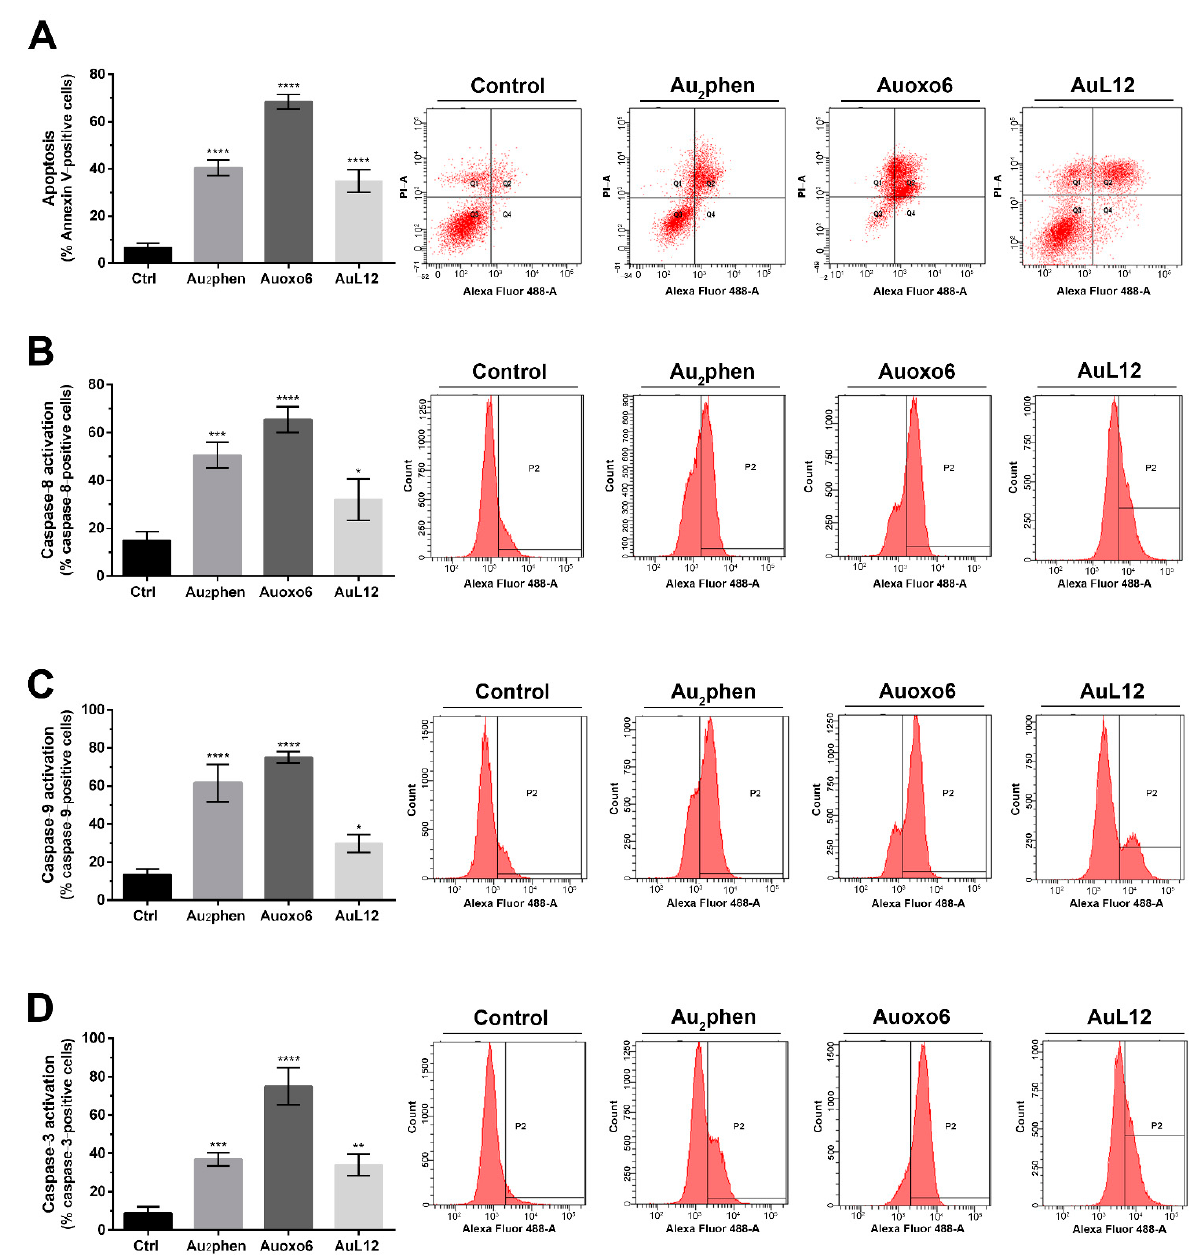
Figure 2. Apoptotic profile analysis and caspases activation: ( A ) percentages of apoptotic cells shown by flow cytometry analysis of annexin V/propidium iodide-stained A2780 cells treated for 72 h with Au 2 phen, Auoxo6, and AuL12 IC 50 doses; ( B ) caspase-8, ( C ) caspase-9, and ( D ) caspase-3 activity shown by fluorescence-activated cell sorting analysis using FAM FLICA caspase assay kits in A2780 cells treated for 72 h with gold(III) complex concentrations corresponding to their 72 h IC 50 dose. Flow cytometric images are representative of three independent experiments. Histograms report the mean values ±SD. The statistical analysis was carried out using one-way ANOVA test followed by Tukey’s multiple comparisons test using GraphPad Prism software v 6.0 (* p < 0.05, ** p < 0.01, *** p < 0.001, **** p < 0.0001).